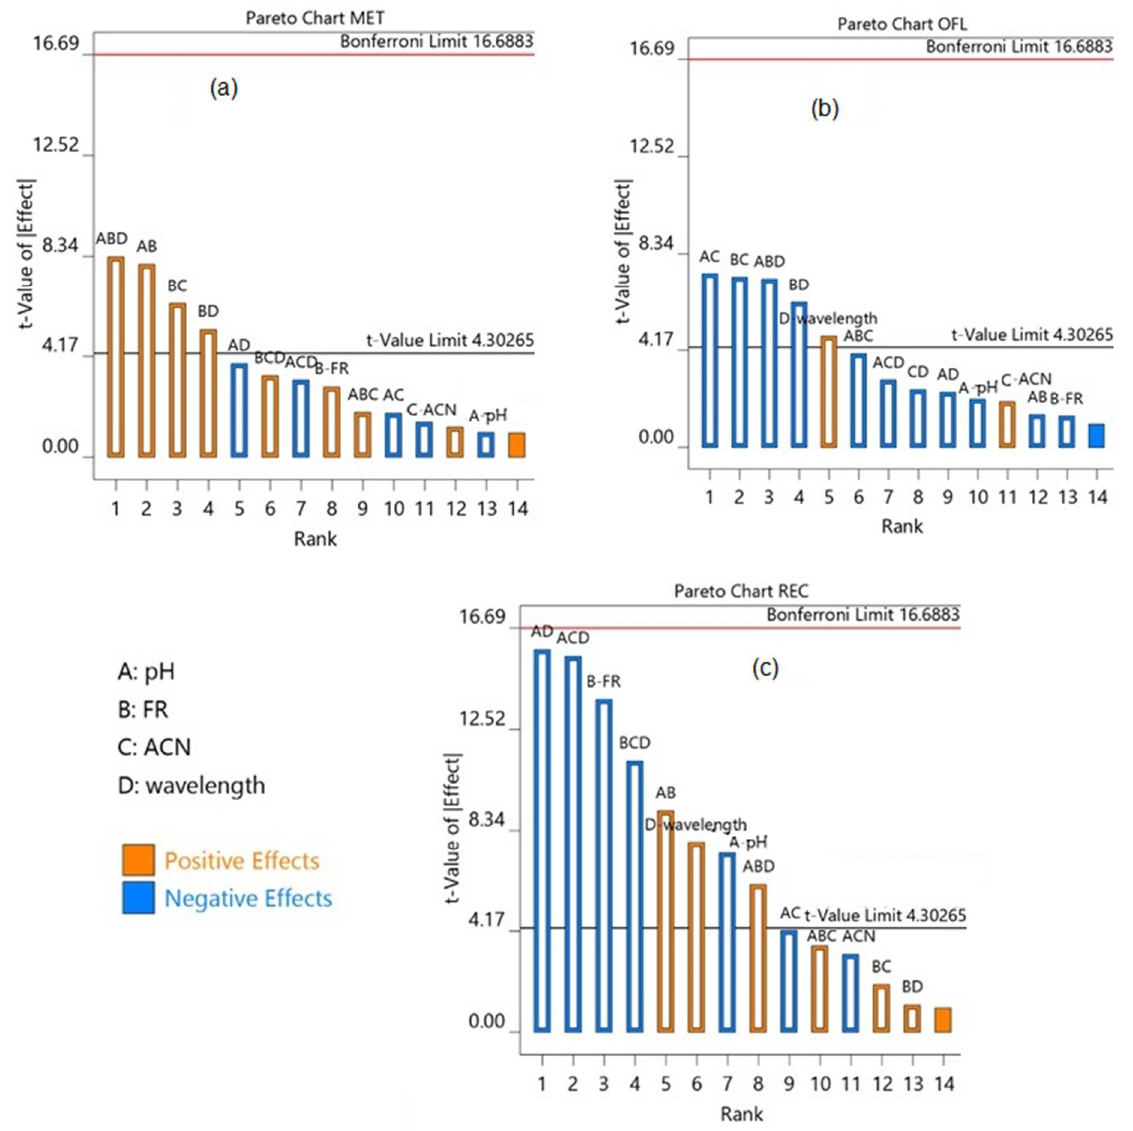
Figure 5. Pareto chart for ( a ) metronidazole, ( b ) ofloxacin, and ( c ) racecadotril. Chromatography parameters (A) pH (5.8, 6, and 6.2), (B) flow rate (1.3, 1.4, and 1.5 mL/min), (C) concentration of acetonitrile (53, 55 and 57%) and (D) wavelength (293, 295, and 297 nm for MET and OFL; 229, 231, and 233 nm for RAC). FR: Flow Rate, ACN: Acetonitrile.